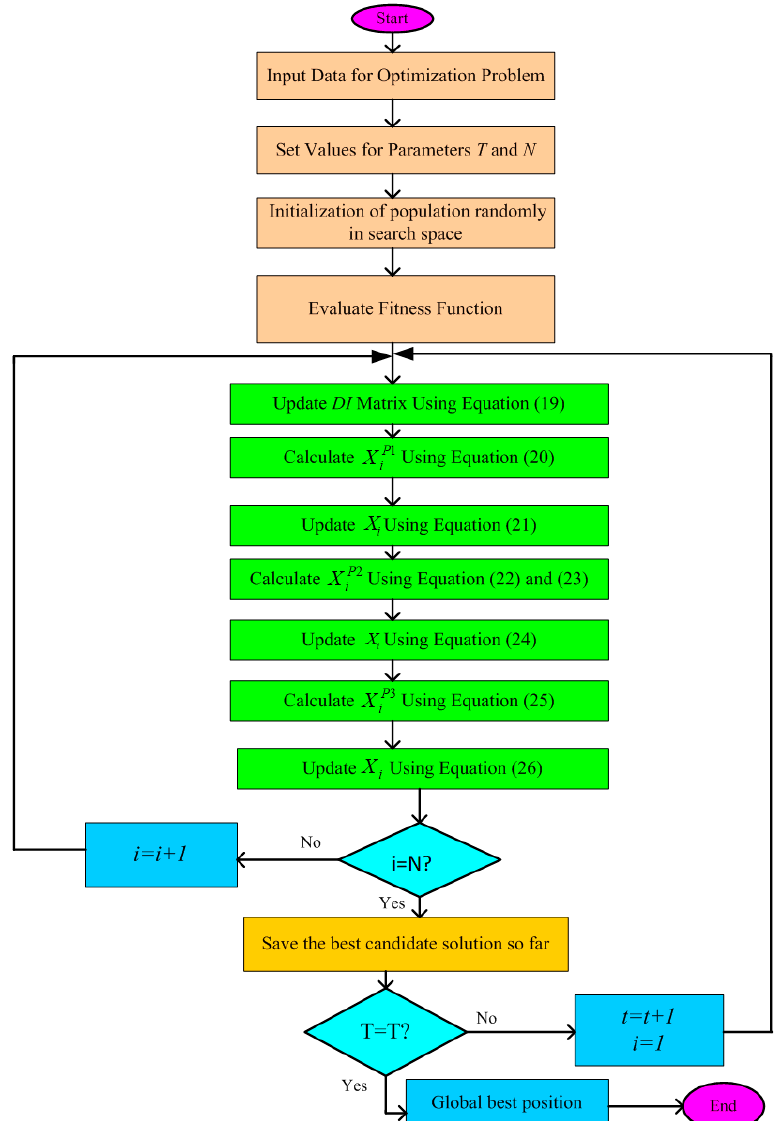
Figure 4. The flowchart for the suggested DTBO approach.